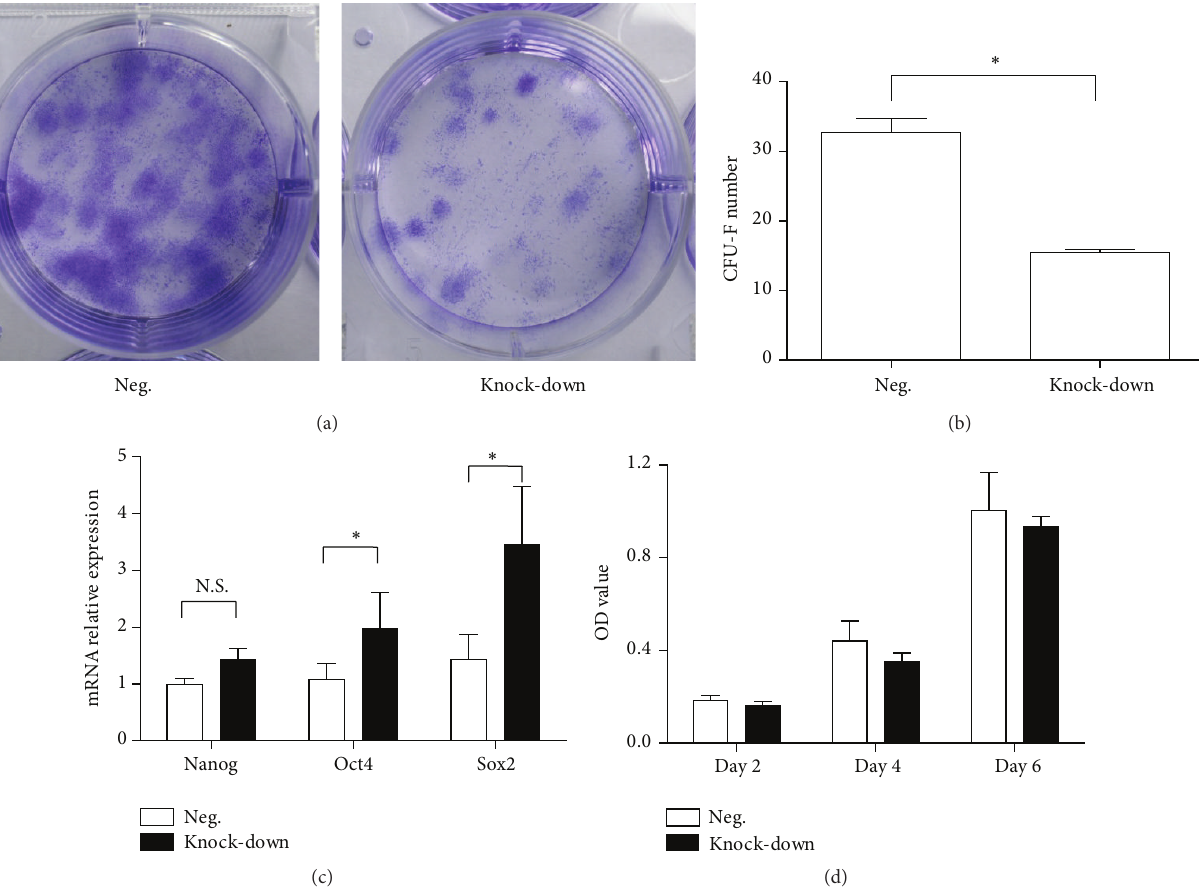
Figure 3: Self-renewal of transfected BM-MSCs. (a) Representative CFU-F of transfected BM-MSCs in a 6-well plate. (b) Mean value ( ± SD) of CFU-F number in different groups. (c) Mean relative values ( ± SD) of NANOG , OCT4 , and SOX2 mRNA expression in different groups. (d) Mean value ( ± SD) of OD values in different groups detected by MTT